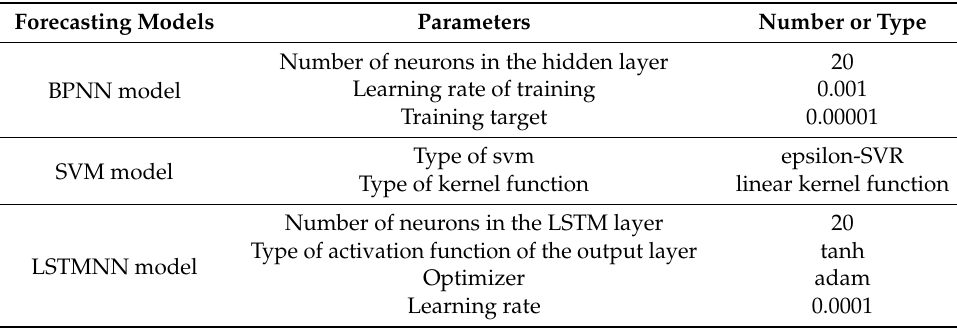
Table 3. Parameter settings of wind speed forecasting model.